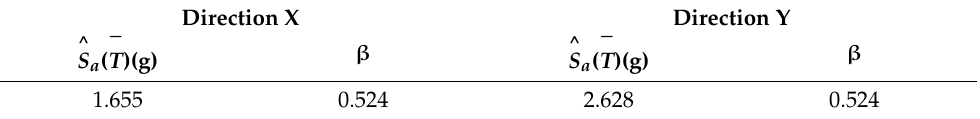
Table 5. Parameters obtained for the threshold state of collapse of the structure in the X and Y